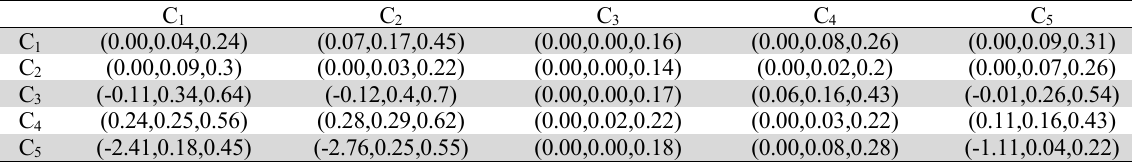
Total-relation fuzzy matrix